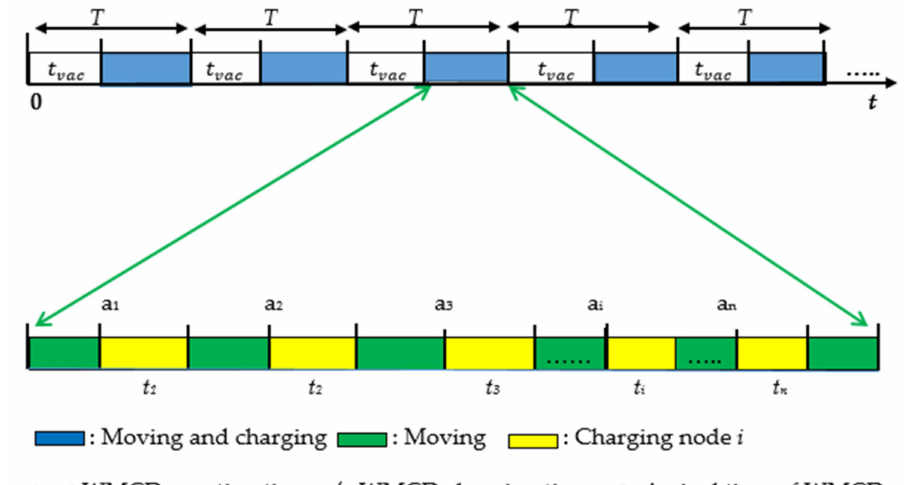
Figure 2. Periodic charging